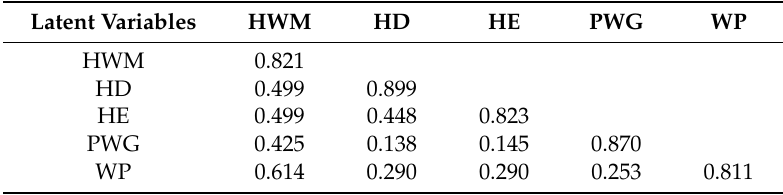
Table 4. Discriminant validity based on the Fornell–Larcker criterion. Latent